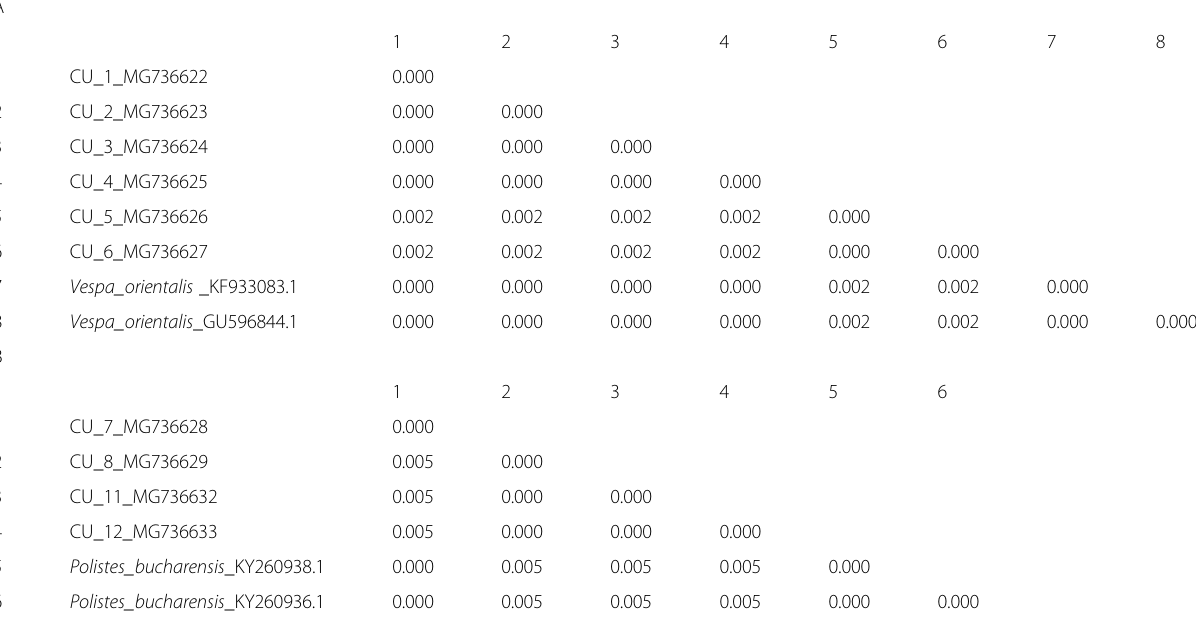
Table 2 Pairwise genetic distances of the analyzed COI gene inside the Vespa orientalis group (A) and inside the Polistes bucharensis group (B). The pairwise distance was calculated using the Kimura two-parameter